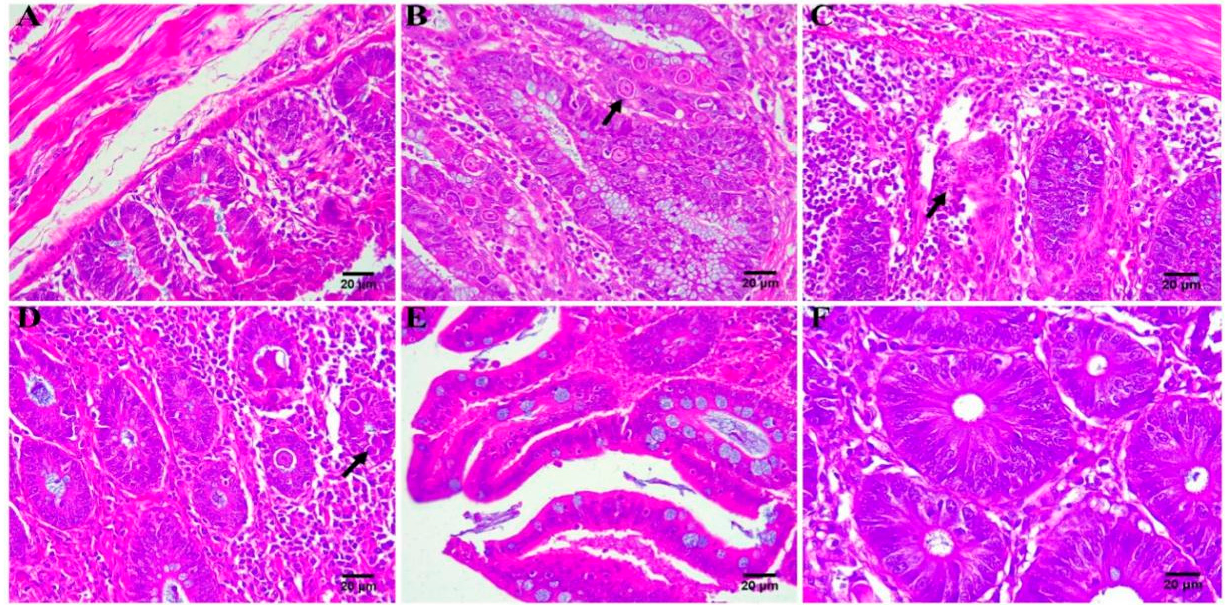
Figure 5. Histopathological analysis of chicken ceca ( n = 3). ( A ) Uninfected–untreated group. ( B ) Infected–untreated group (black solid arrow represents coccidia oocysts). ( C ) MAD premix group(black solid arrow represents structural disorders). ( D ) Low-dose group of MAD–NLCs (black solid arrow represents coccidia oocysts). ( E ) Medium-dose group of MAD–NLCs. ( F ) High-dose group of MAD–NLC structural disorders.